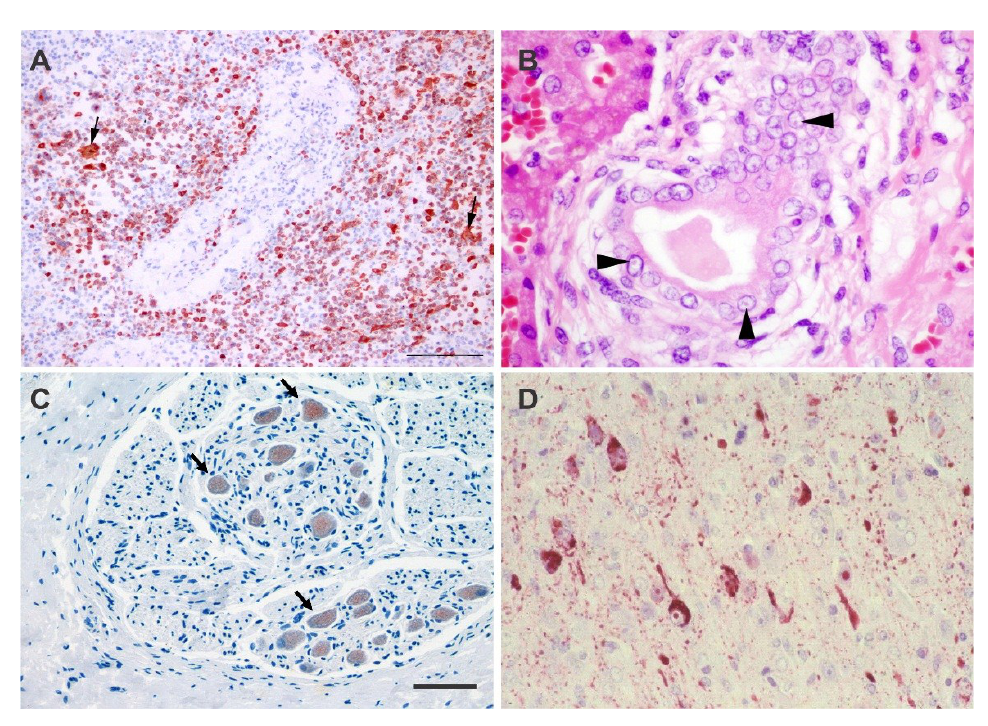
Brazil, 2010. Granular immunohistochemical staining of